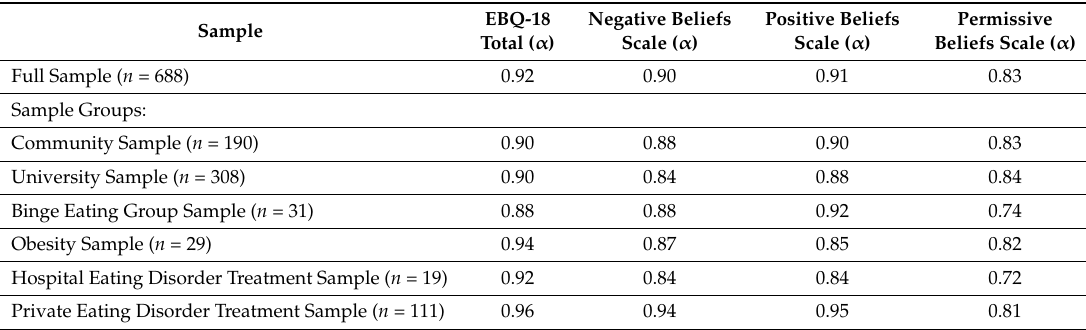
Table 3. Internal Consistency of EBQ Scales across Different Sample